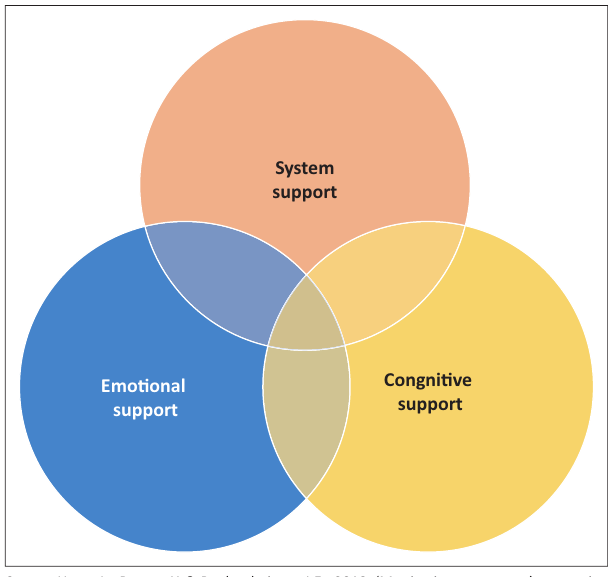
FIGURE 1: Preceptors’ support